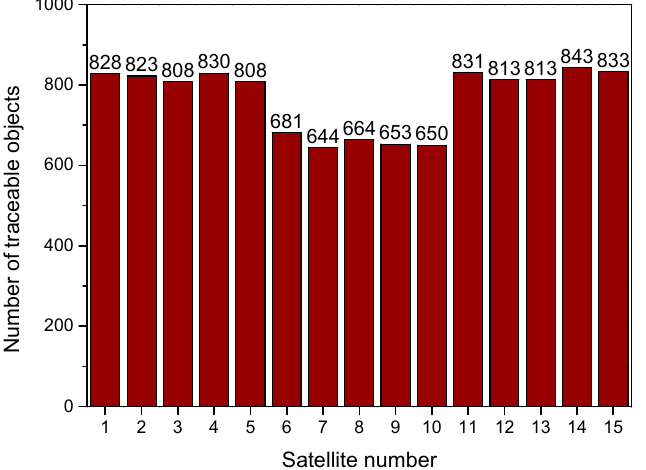
Figure 13. Proportion of objects that can be tracked within 24 h in the different constellation configurations.